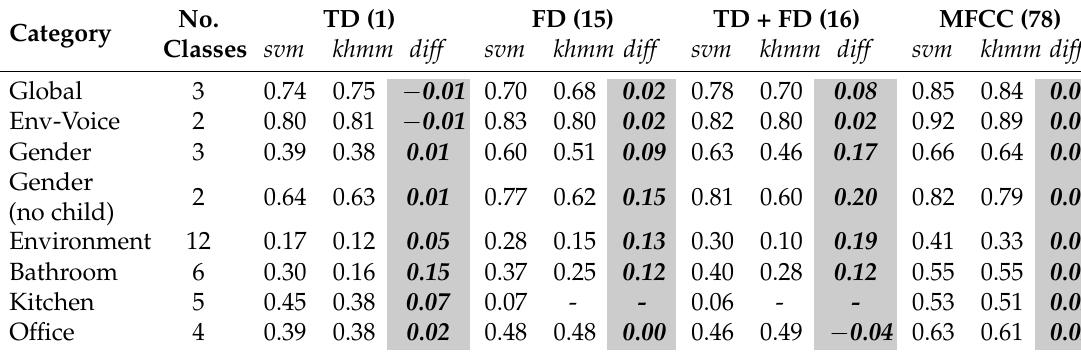
Table 4. Classification Results for window size 0.25 s. RET in brackets for each